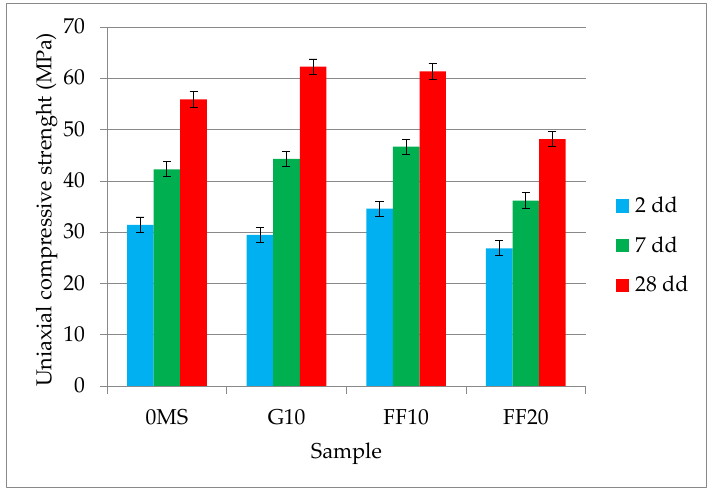
Figure 7. Compressive strength histogram of the specimens of the 0MS, G10, G20, FF10, FF20 at 2, 7, and 28 days of curing.